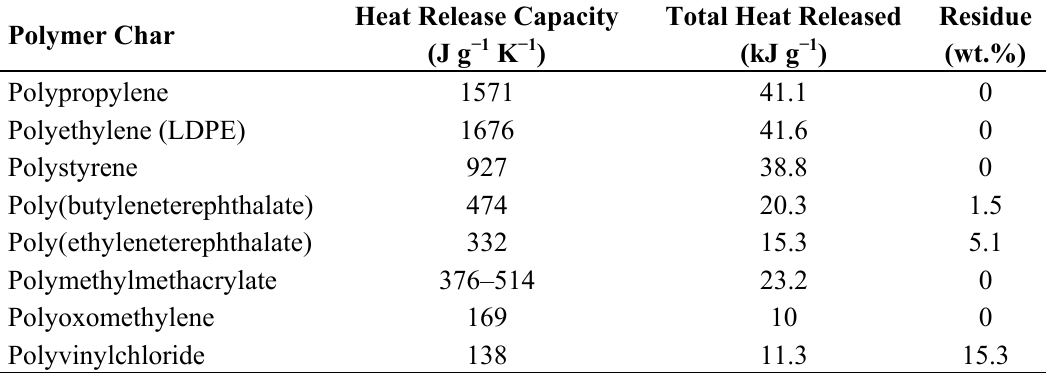
Table 3. Heat release capacity, total heat released, and char yield of selected polymers [11].